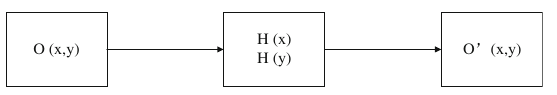
Fig. 8 Position estimation block diagram